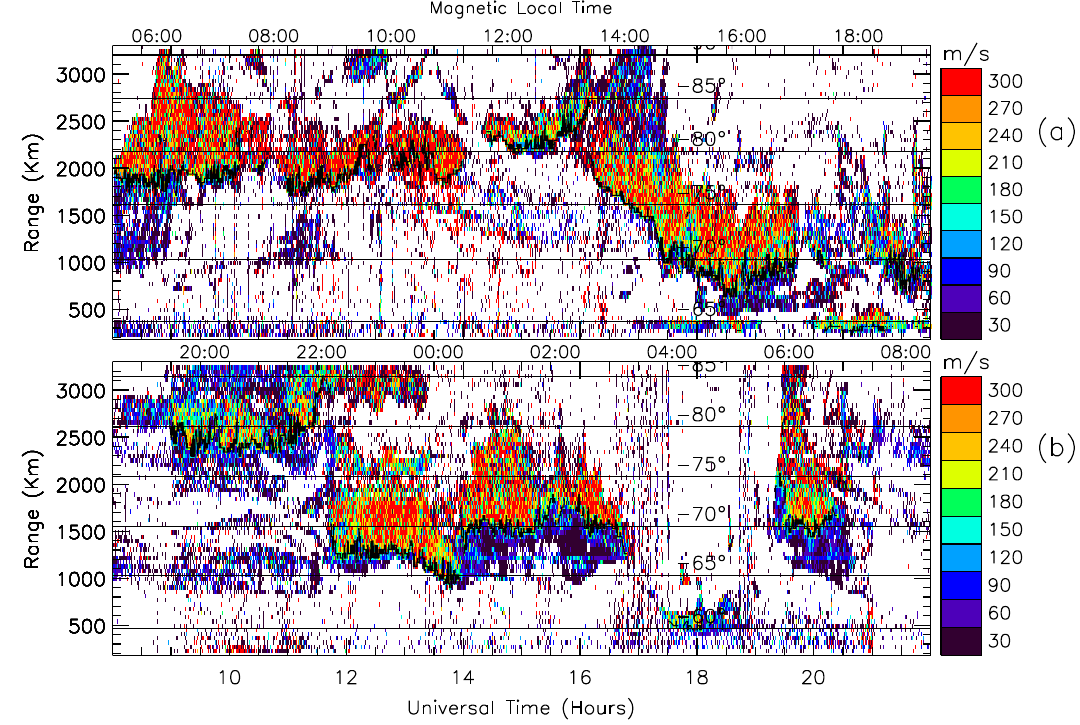
Fig. 3. Range-time plots of radar spectral widths measured on (a) Halley beam 8 and (b) TIGER beam 4 at 6-s time steps during 08:00 to 22:00 UT, 1 April 2000. Ground scatter generally has very low spectral widths and was not included in these plots. Significant changes in the operating frequency of TIGER occurred at 09:00 and 21:00 UT. Bold, fluctuating curves delineate the spectral width boundaries (SWBs) identified using the C-F algorithm with a threshold of 150ms − 1 . The thin horizontal lines represent magnetic latitudes between − 65 ◦ and − 85 ◦ , and corresponding MLTs are shown at the top of each